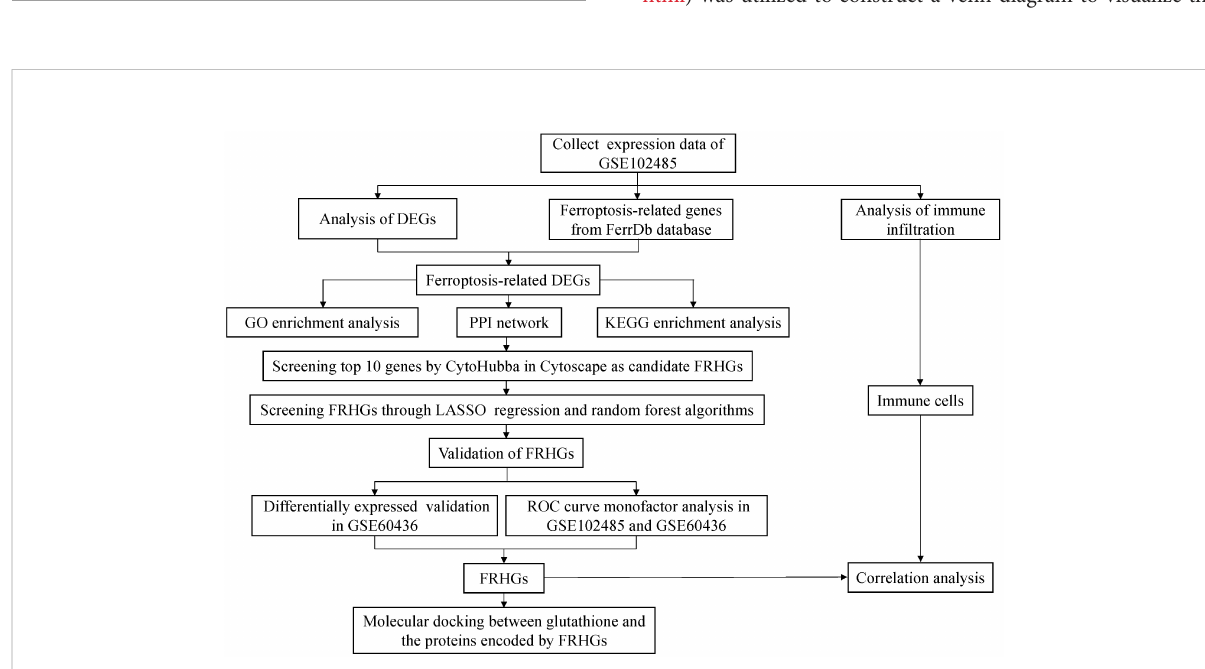
FIGURE 1 Work fl ow of data analyses utilized in this study. DEGs, differentially expressed genes; GO, Gene Ontology; PPI, protein-protein interaction; KEGG, Kyoto Encyclopedia of Genes and Genomes; FRHGs, ferroptosis-related hub genes; LASSO, least absolute shrinkage and selection operator; ROC, receiver operator